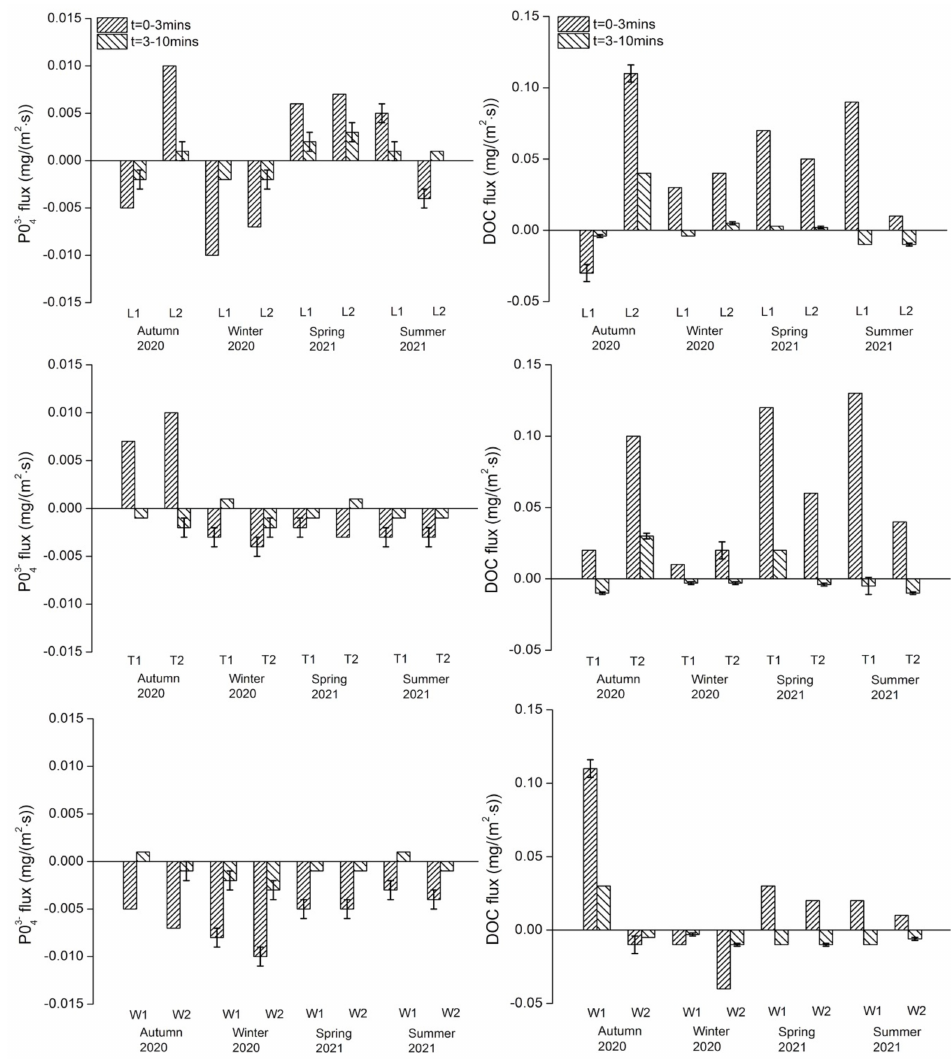
Figure 5. PO 43 − and DOC fluxes of sampling events during the study period for each study river. Downwards flux represents uptake/removal of nutrients from overlying water to sediment and up- wards flux represents regeneration/release of nutrients from sediment to water. The flux experiment at each site has three replicates, if the results are different, the error line is marked on the bar. Dissolved organic carbon: DOC fluxes in both exposure periods ranged from −